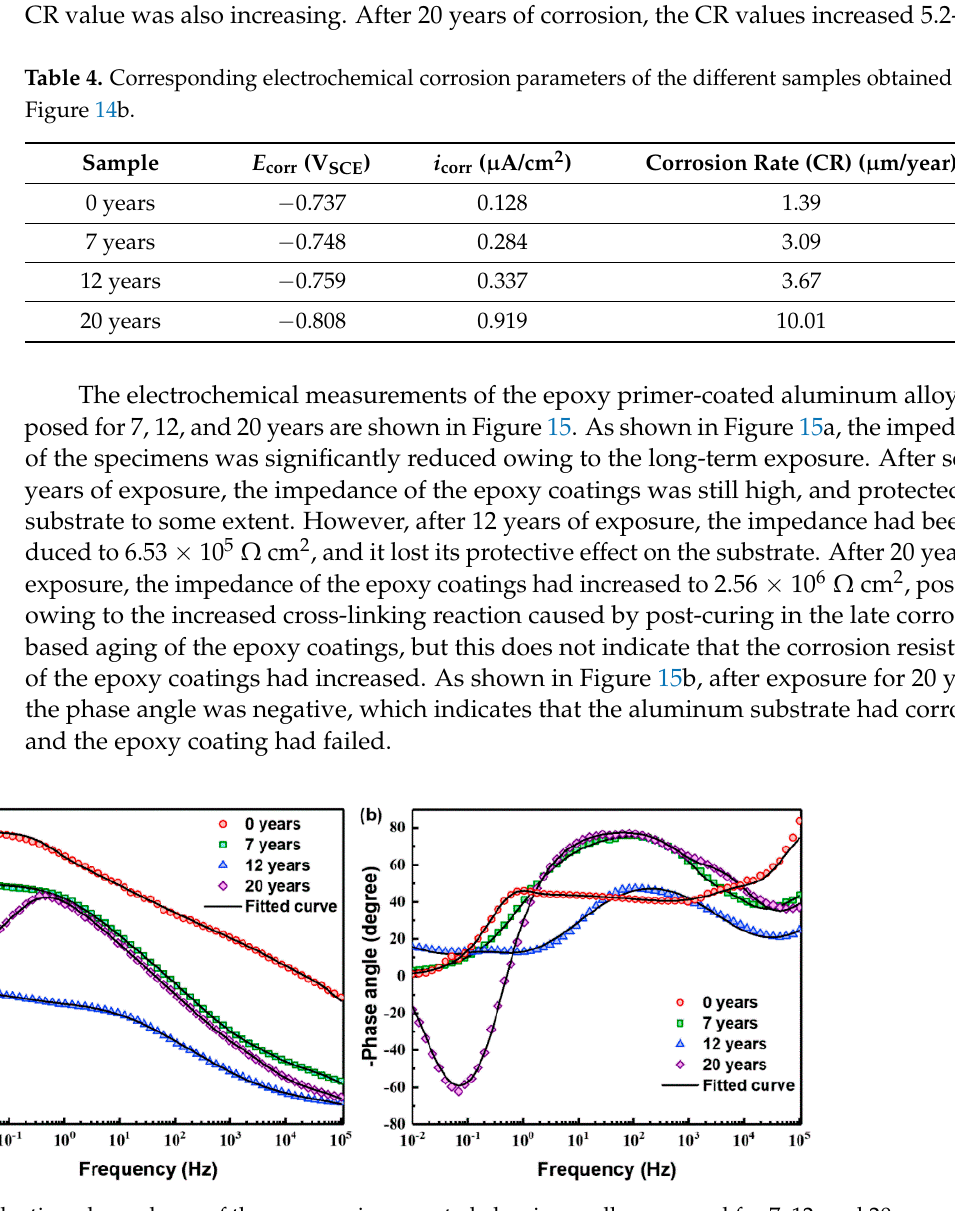
Figure 15. Bode plots of the time dependence of the epoxy primer-coated aluminum alloy exposed for 7, 12, and 20 years. ( a ) Bode phase angle as a function of log(f), in units of Hz, and ( b ) Bode log|Z| as a function of log(f), in units of Hz. The ‘f’ in log(f) is logarithm of